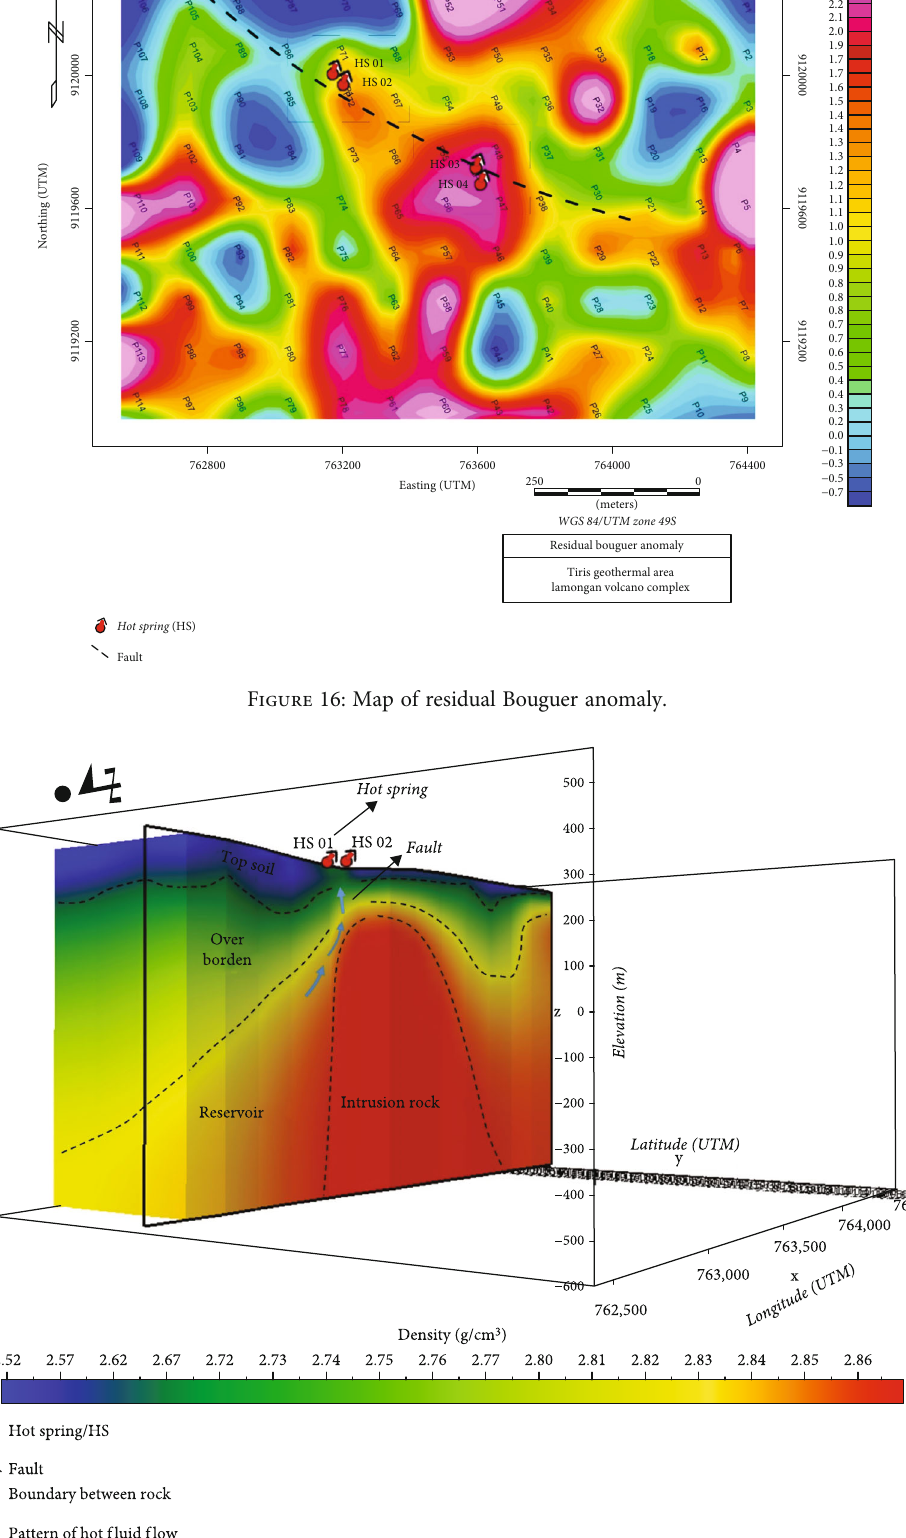
Figure 17: Conceptual form of subsurface conditions at the Tiris geothermal